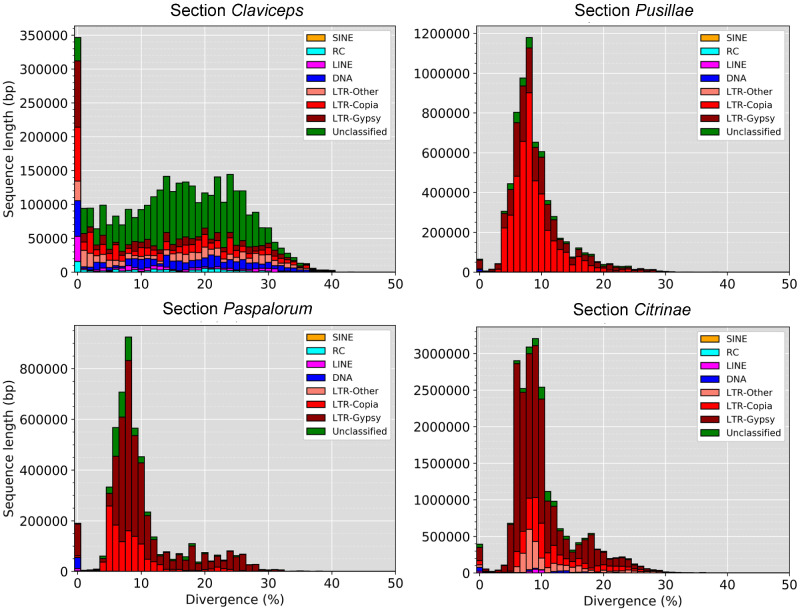
TE fragment divergence landscapes for representative species of each Claviceps section; C. purpurea 20.1 (sect. Claviceps), C. maximensis CCC398 (sect. Pusillae), C. paspali RRC1481 (sect. Paspalorum), and C. citrina (sect. Citrinae). Stacked bar graphs show the nonnormalized sequence length occupied in each genome (y axis) for each TE type based on their percent divergence (x axis) from their corresponding consensus sequence. Landscape for all remaining isolates can be seen in supplementary figure S8, Supplementary Material online.